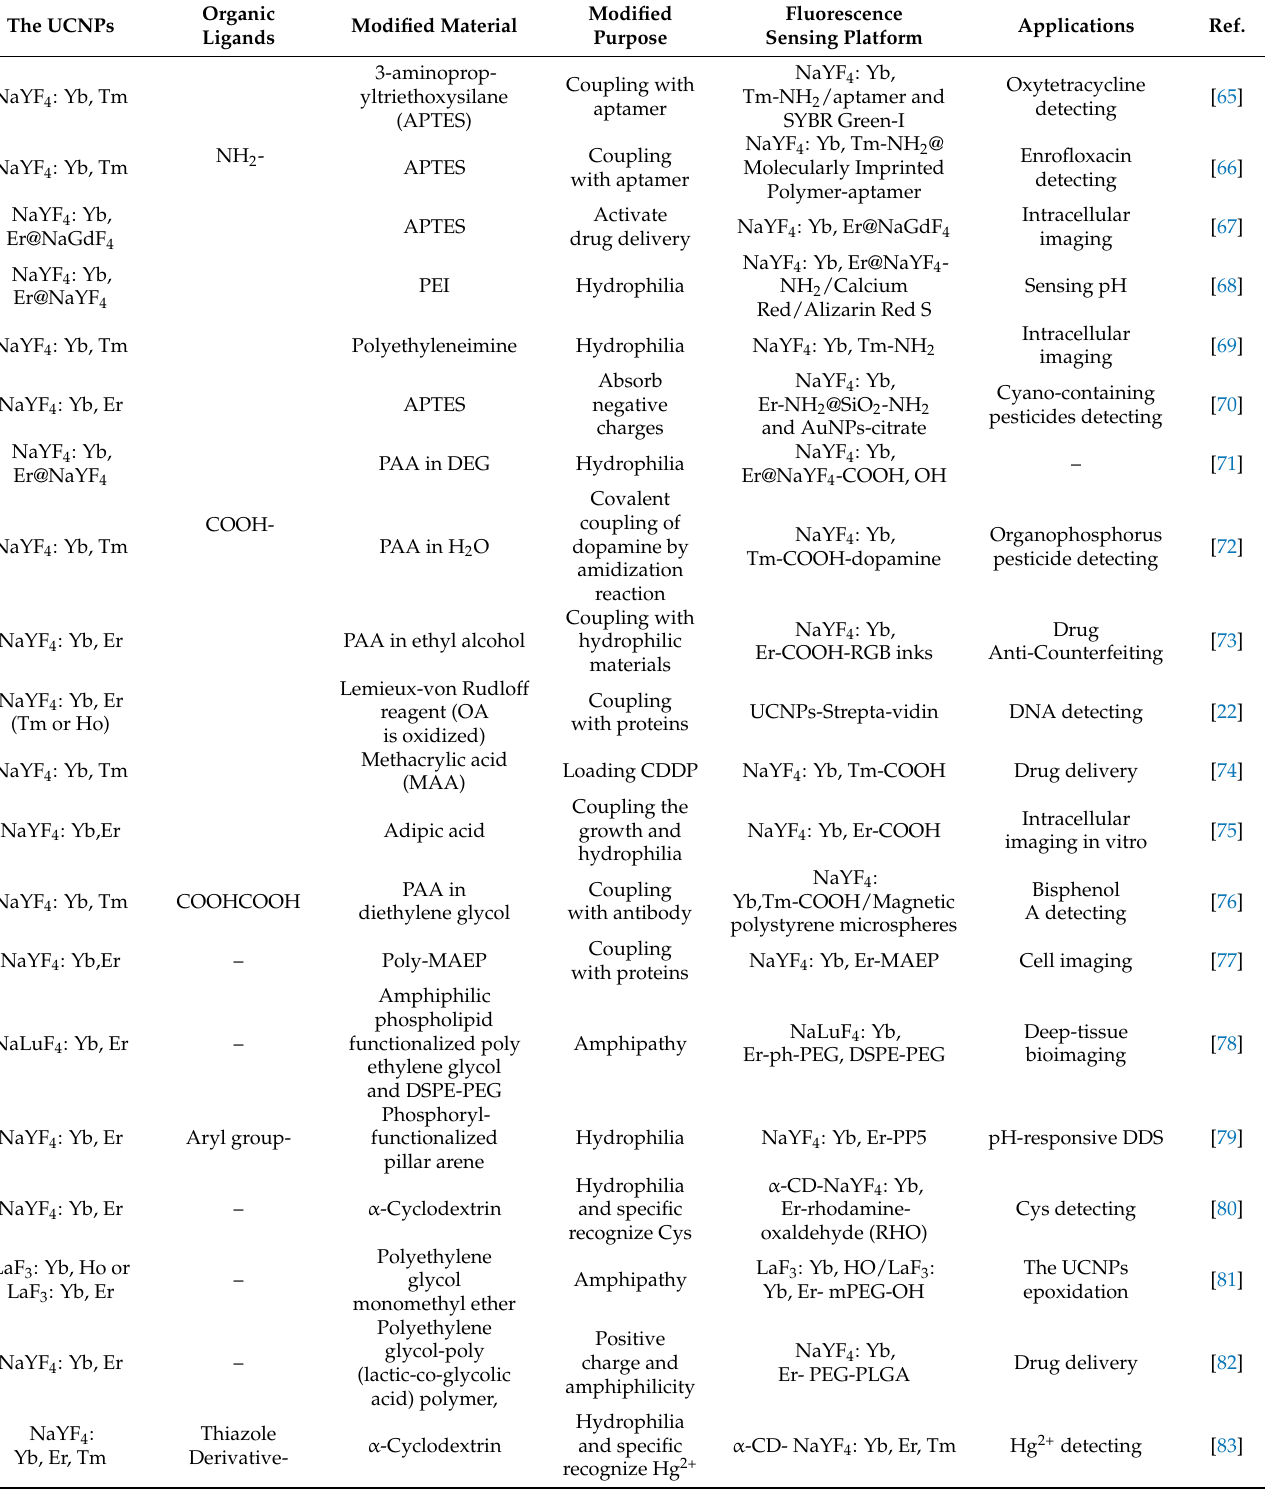
Table 2. Upconversion modifications and surface